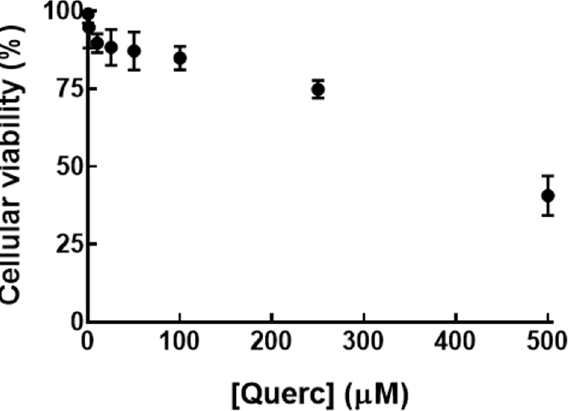
Figure 5. HepG2 cells viability after incubation with free quercetin for 24 h. Viability was determined